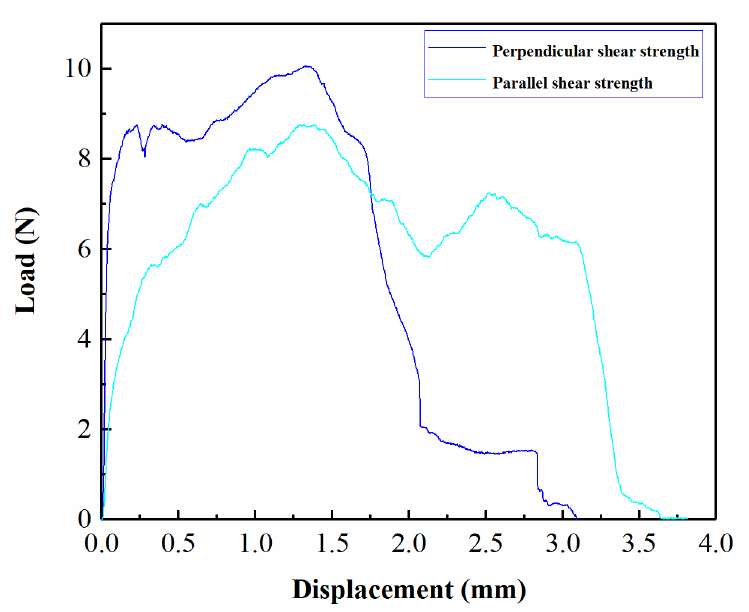
Figure 23. Load–displacement curves for parallel shear strength and perpendicular shear strength for joints with a thickness combination of 100/100 μm (H = 500 μm, En 1 = 1690 mJ, En 2 = 1020 mJ).